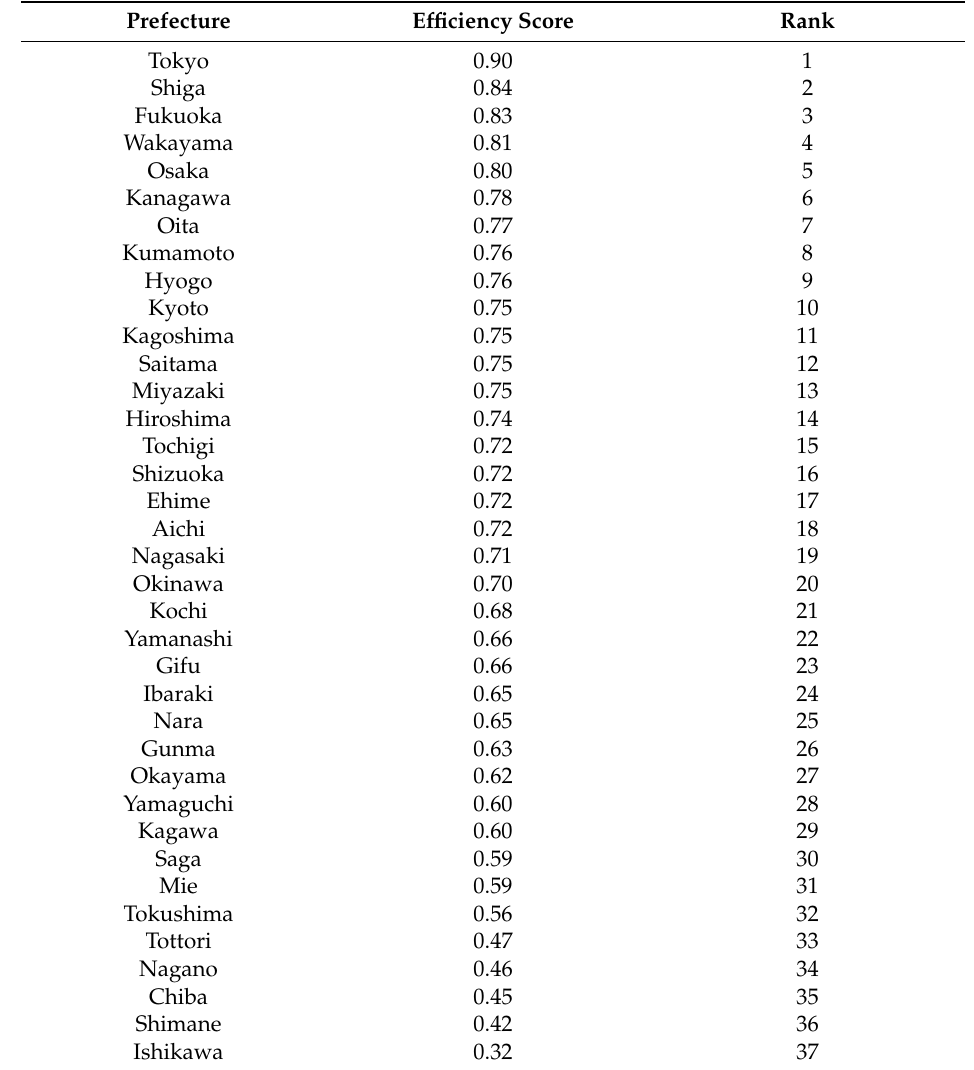
Table 5. Average Energy Efficiency Scores and